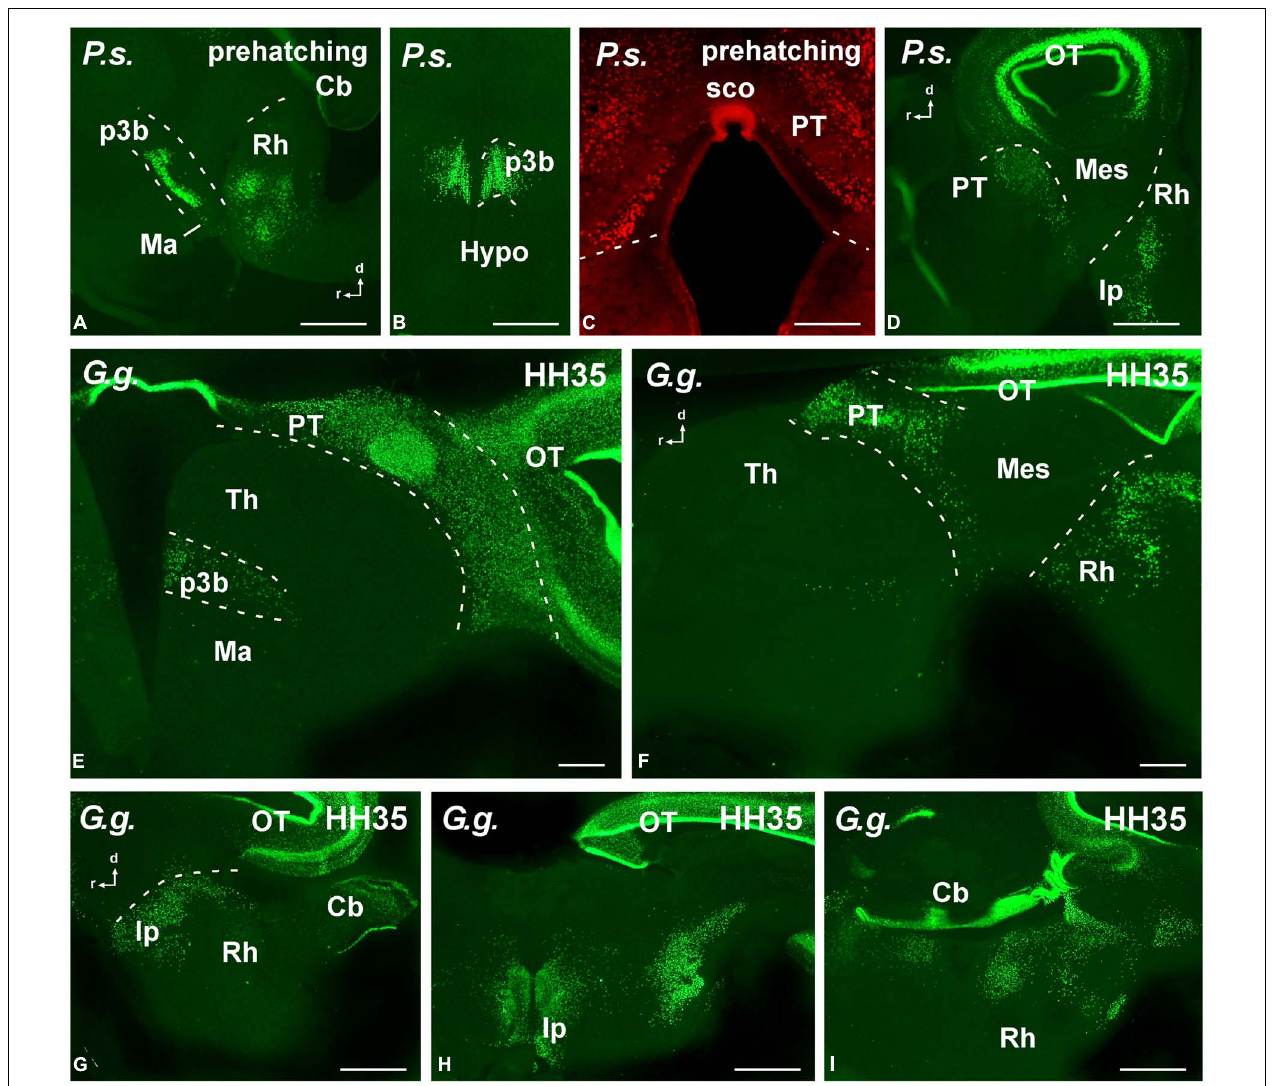
FIGURE 8 | Photomicrographs of transverse (B,C,E,H,I) and sagittal (A,D,F,G) sections that serve to illustrate the localization of Pax7-immunoreactive cells in the brain of the amniotes Pseudemys scripta ( P.s. ) just at prehatching stages (A–D), Gallus gallus ( G. g. ) at